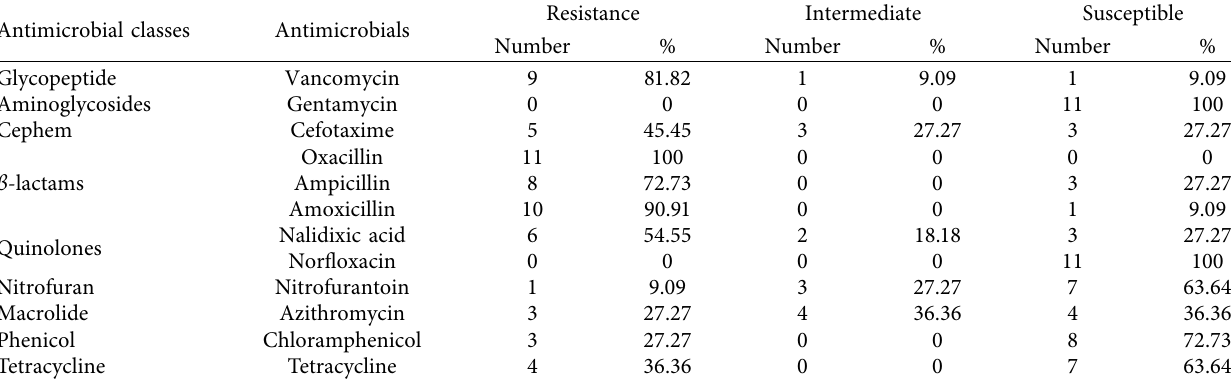
Table 6: Results of antimicrobial susceptibility testing of L. monocytogenes isolates ( N � 11) from all samples in this study town. Antimicrobial classes